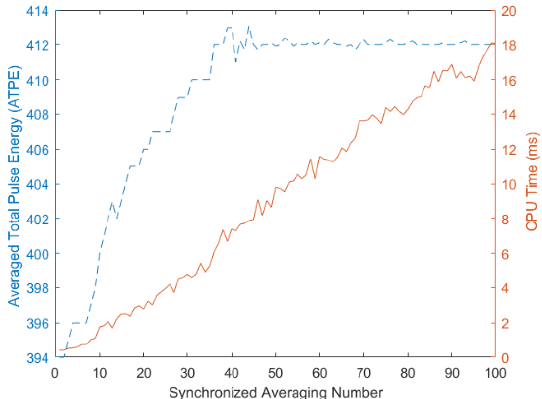
Figure 5. A double y -axis graph: Variation of the C 0 values under different period numbers for ensemble averaging on the left y -axis. The secondary vertical axis for CPU time (ms) is added on the right for Subject A.